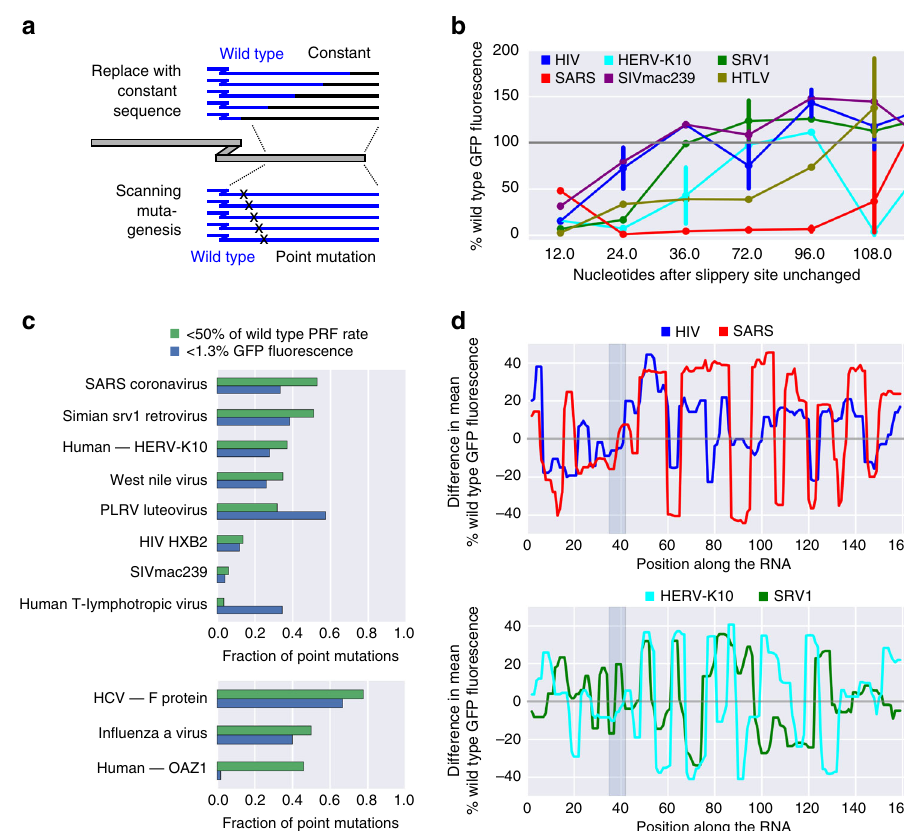
Fig. 3 PRF sites exhibit different sensitivities to changes in the downstream sequence. a Schematic of downstream sequence manipulations. b Percent wild-type frameshifting rates of variants, in which the native downstream region has been replaced by constant sequences, leaving the indicated number of nucleotides after the slippery site unchanged; n = 1 – 3 per data point and PRF event. c Fraction of point mutations in the 40 nt downstream of the slippery site resulting in <50% of wild-type GFP fl uorescence (green) and background fl uorescence (<1.3% GFP fl uorescence, blue), for − 1 (top) and + 1 (bottom) PRF events; n = 51, 47, 54, 23, 47, 51, 49, 29 (upper) and 9, 10, 52 (lower) sequences tested in total. d The difference in mean % wild-type frameshifting between variants, in which the indicated position is predicted to be paired vs. unpaired along the variable region; gray box: slippery